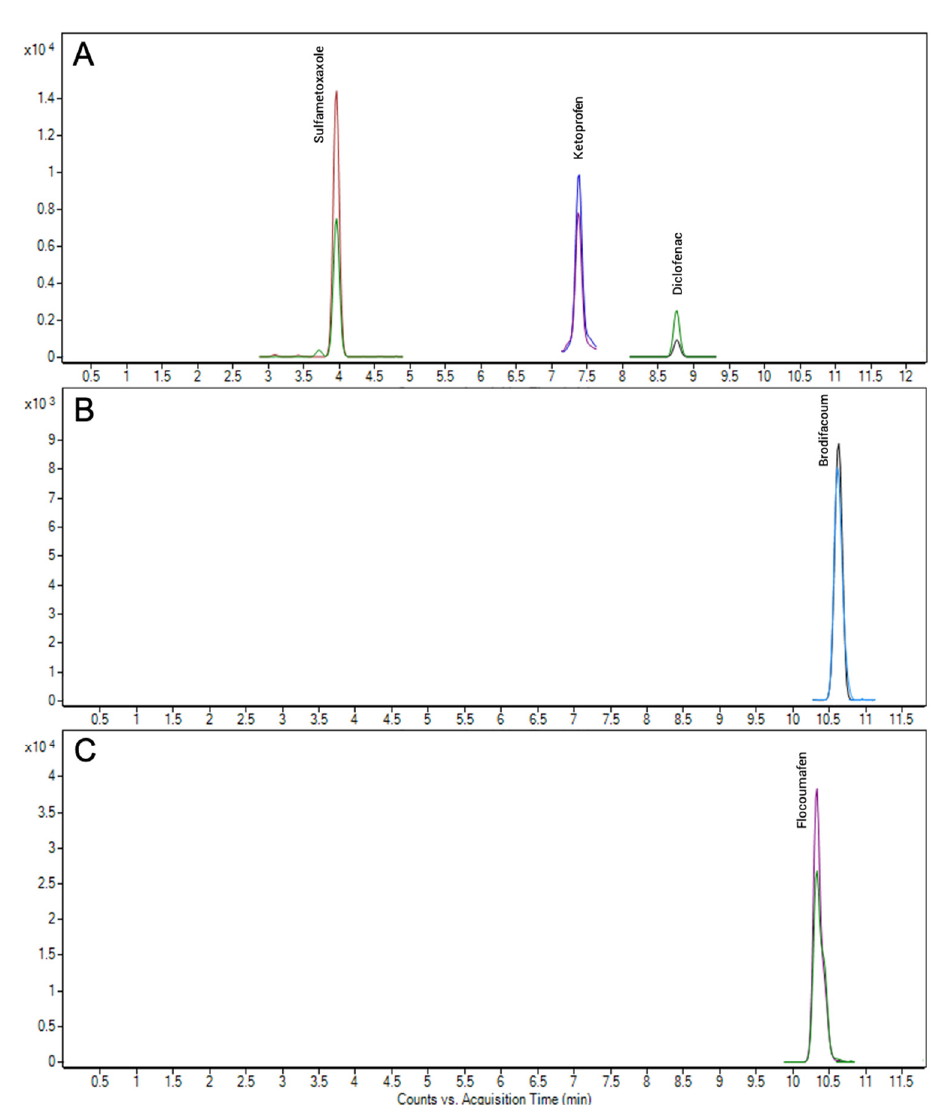
Figure 3. Chromatogram of the regenerated water ( A ) and the two agricultural soils with the identification of ( B ) brodifacoum and ( C ) flocoumafen.